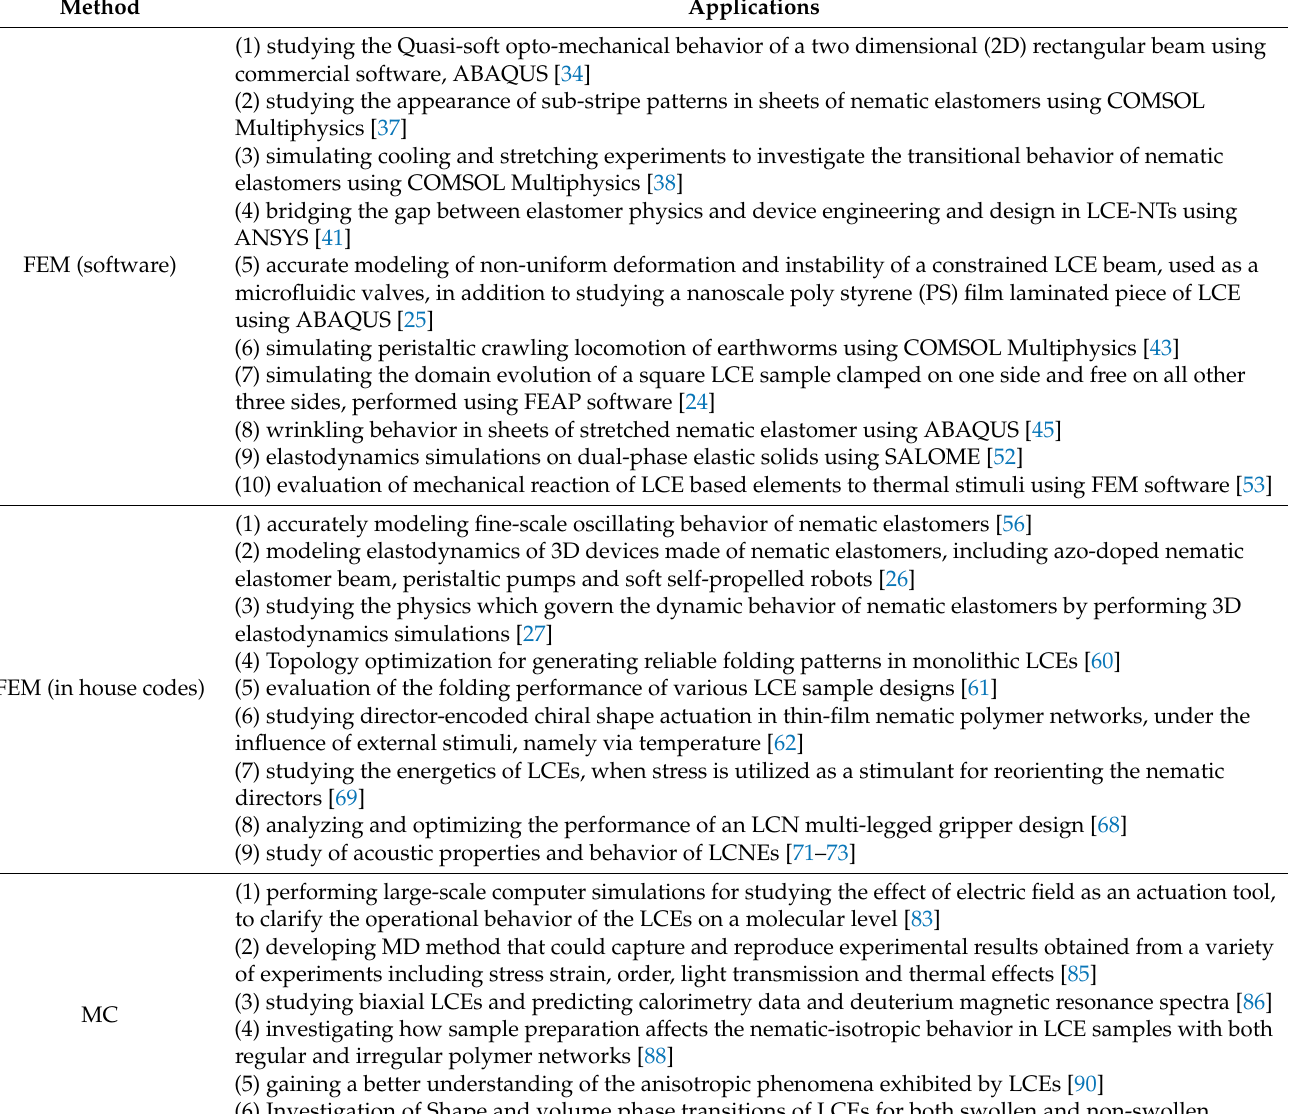
Table 1. Categorization of the reviewed numerical